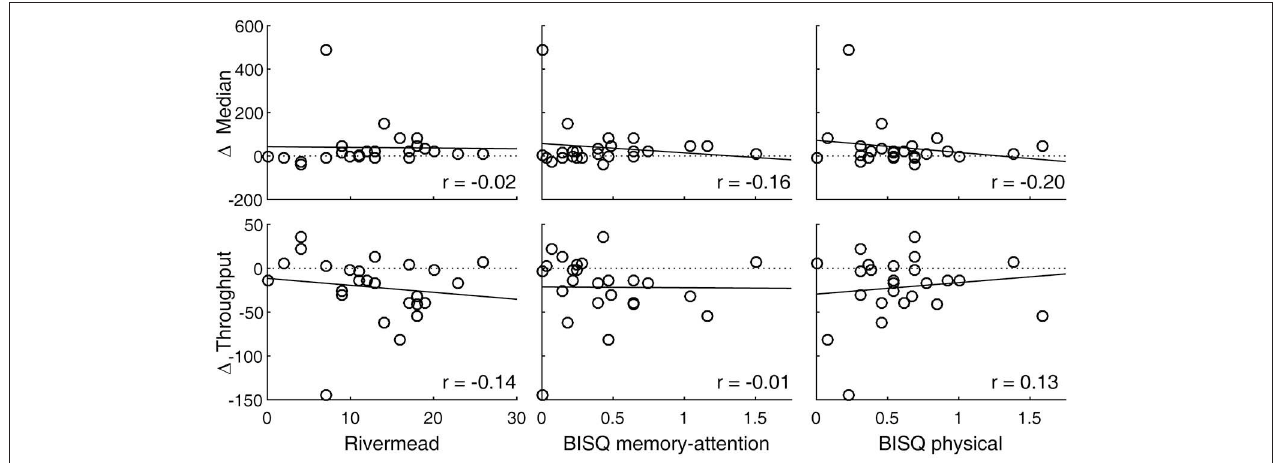
FIGURE 3 | SRT performance changes are associated with post-concussion symptomatology. Circle markers in each panel indicate individual subjects. A regression line is drawn to indicate a trend. A positive change in median or a negative change in throughput indicates slowed reaction. Also see Table 2